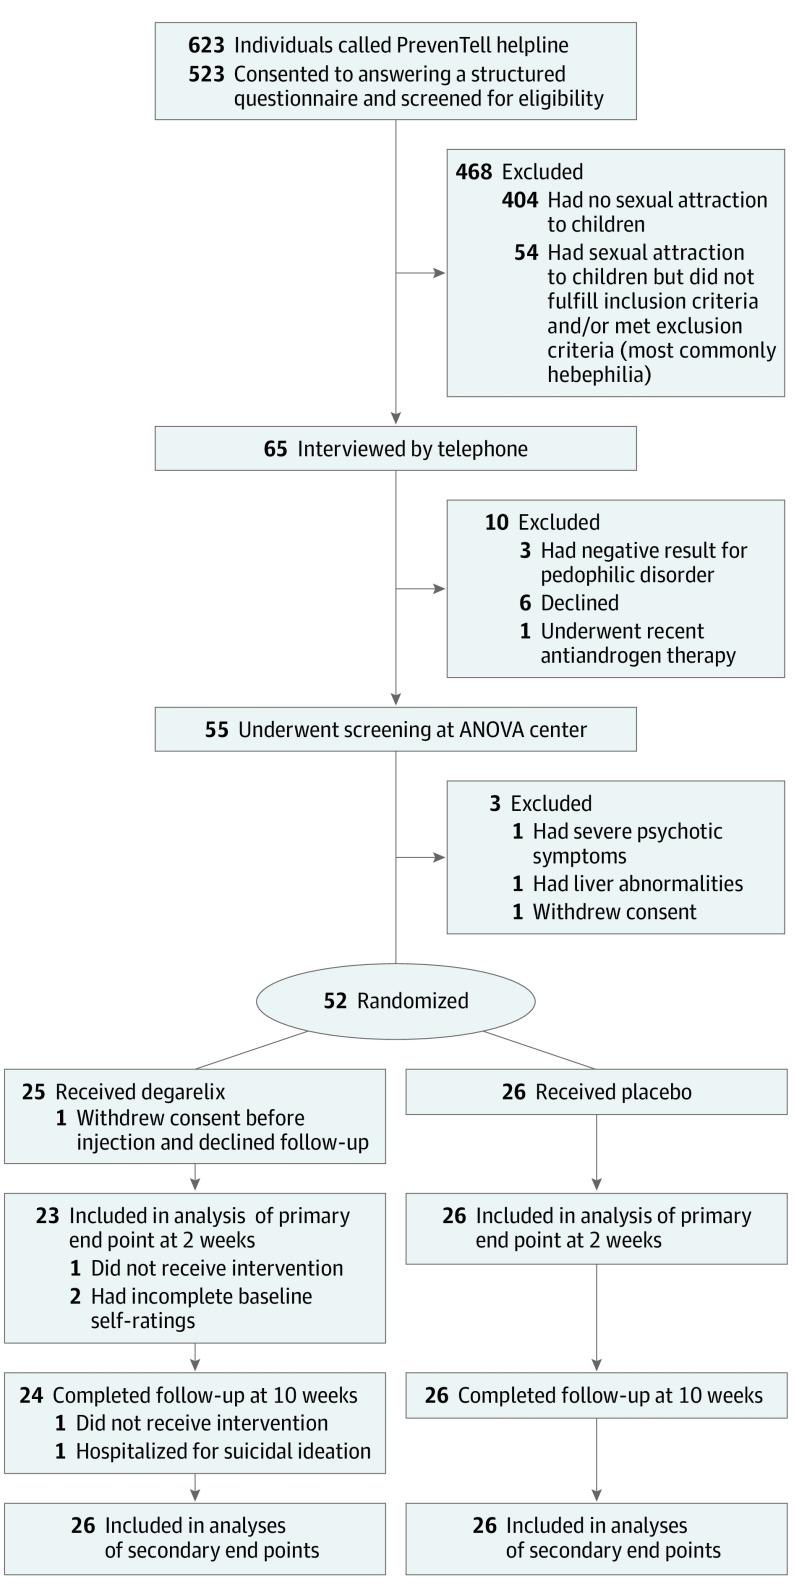
CONSORT Diagram